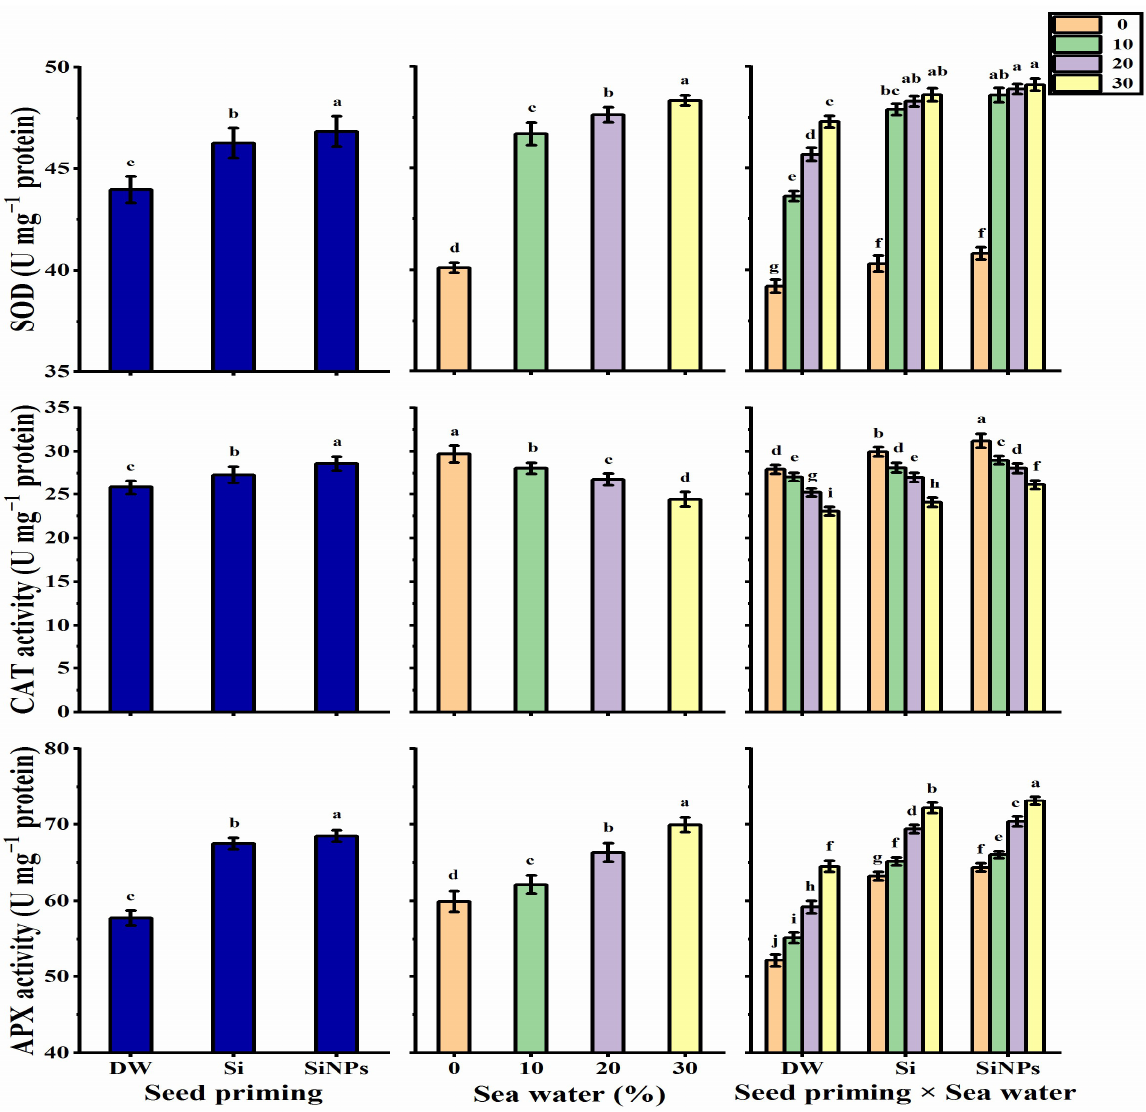
Figure 8. Effect of seed priming on SOD (U mg − 1 protein), CAT (U mg − 1 protein), and APX (U mg − 1 protein) activities of Lathyrus odoratus leaves irrigated with seawater levels (0, 10, 20, and 30%). Data are mean value ± SE. Bars with different letters are significantly different at p ≤ 0.05 level.